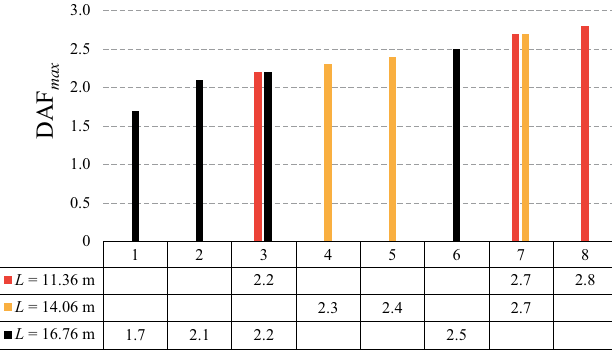
Figure 5. Frame-reinforced beams without